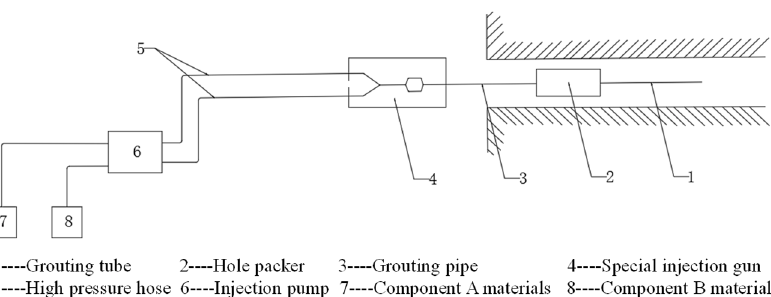
Figure 5. Part drawings of grouting equipment.